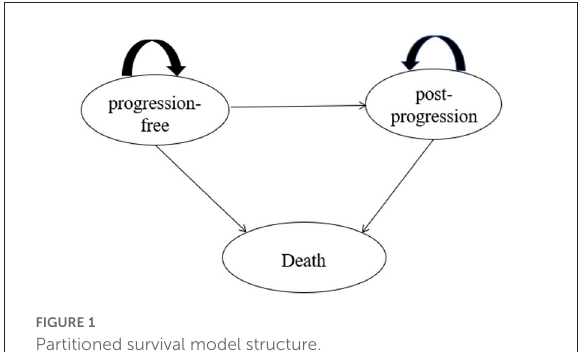
TABLE 1 HRs for PFS and OS after adjustment of two-stage